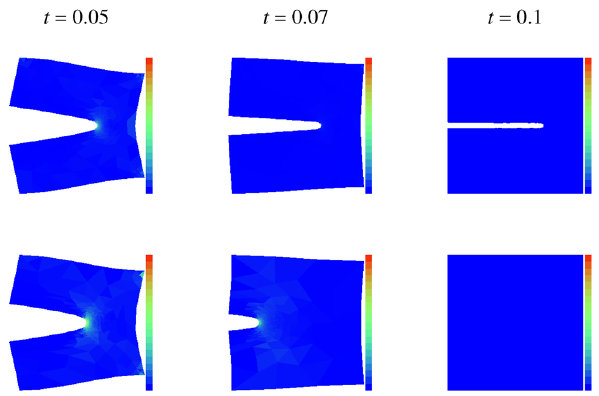
Fig. 6 Crack growth in an isotropic media with the given boundary displacement (3.4) on Γ ± ( α 𝜕 z ∕ 𝜕 t = ( ⋯ ) + (upper) and α 𝜕 z ∕ 𝜕 t = ( ⋯ ) D (lower)). Blue color indicates low values, red color high values of the intensity of